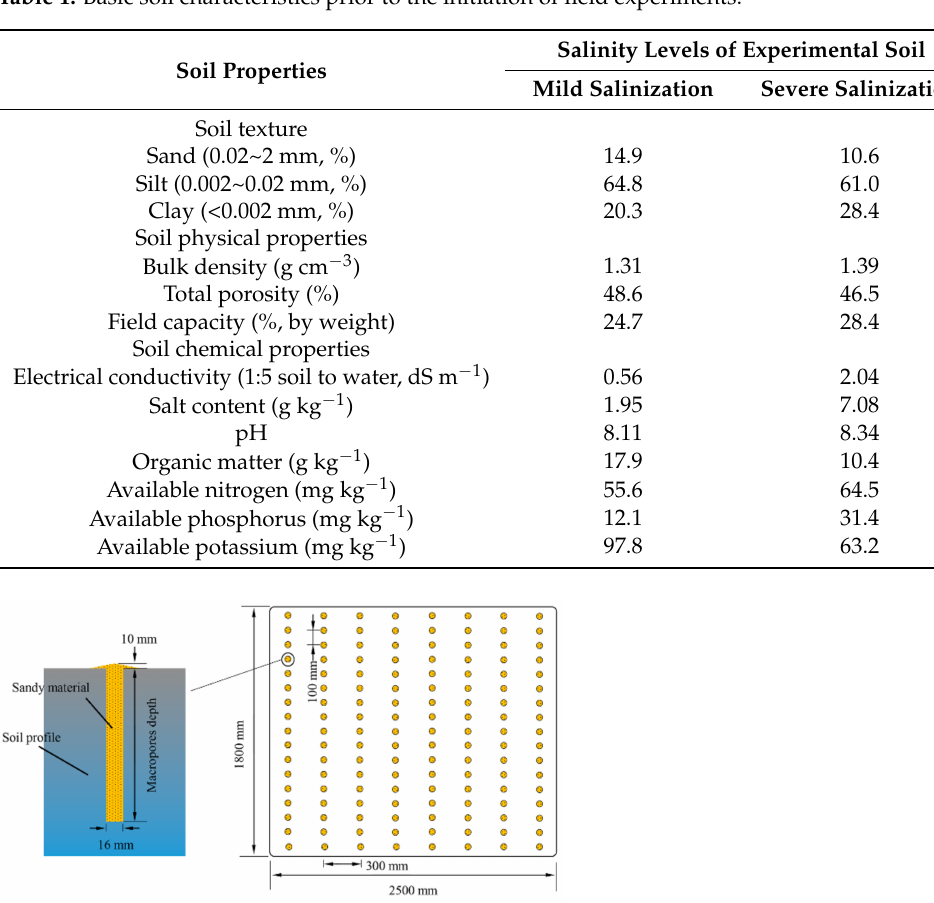
Table 1. Basic soil characteristics prior to the initiation of field experiments.